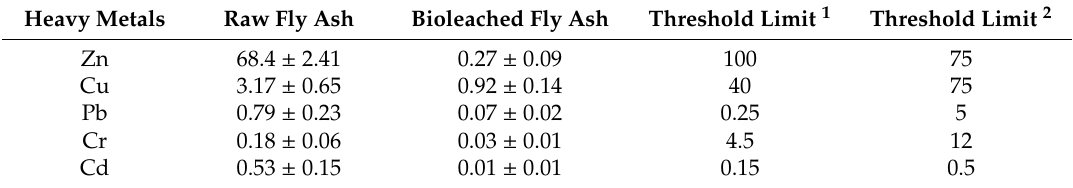
Table 2. Heavy metals extracted from raw and bioleached fly ash according to TCLP (mg / L). Heavy